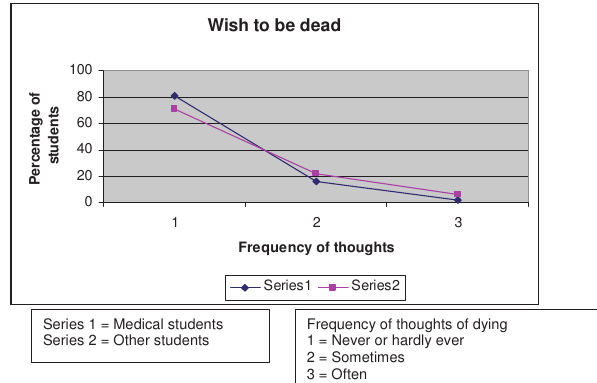
Fig. 6. Previous suicide attempts.